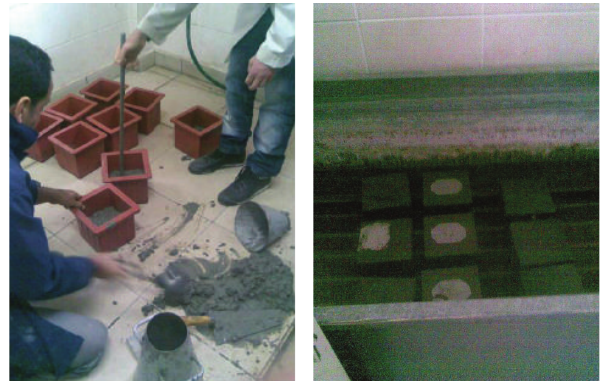
Figure 2: The mixing of fresh concrete and curing processes.